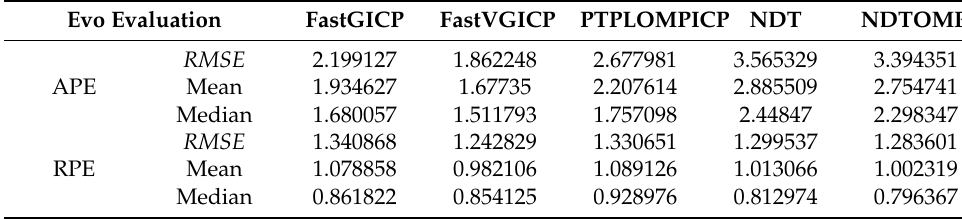
Figure 11. Evo tool RPE evaluation results for FastGICP algorithm. Table 2. The evaluation results of five algorithms using evo